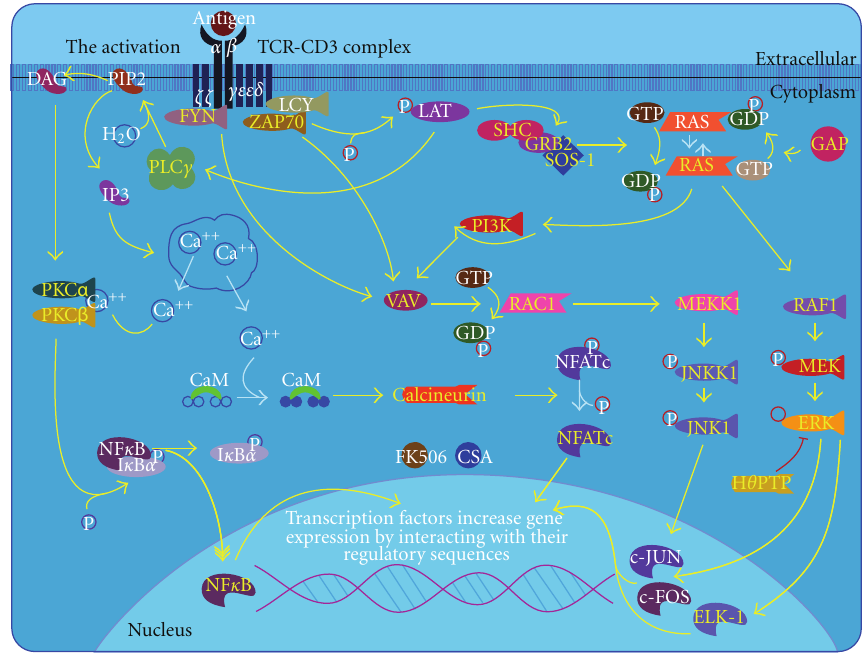
Figure 2: T cell receptor signaling pathway extracted from BioCarta database [9].